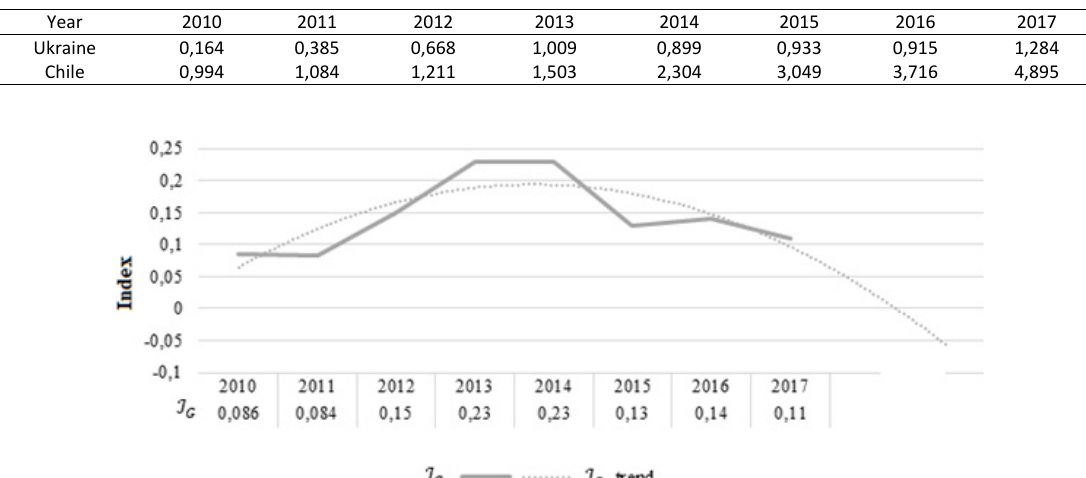
Table 1: Installed capacity in Ukraine and Chile 2010 vs 2017, GW Table 2: Generation in Ukraine and Chile 2010 vs 2017, TW/h